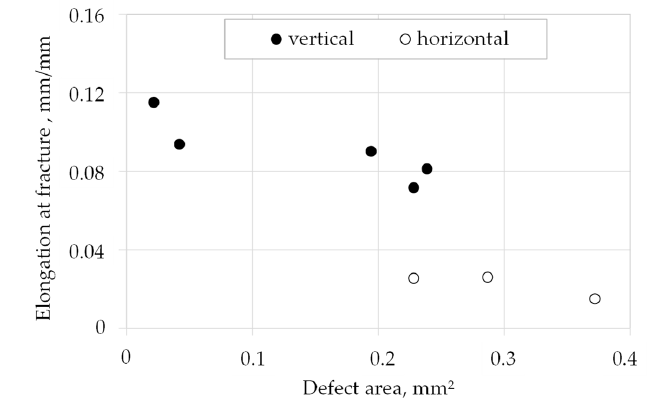
Figure 6. Correlation between defect area and elongation at fracture of vertically and horizontally built tensile specimens.